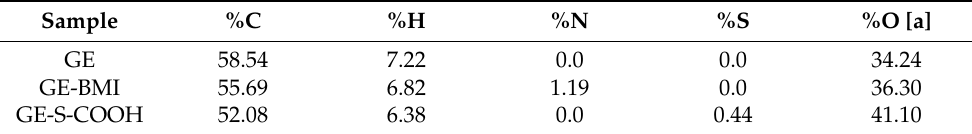
Table 7. The results of the CHNS elemental analysis of polymeric microspheres.